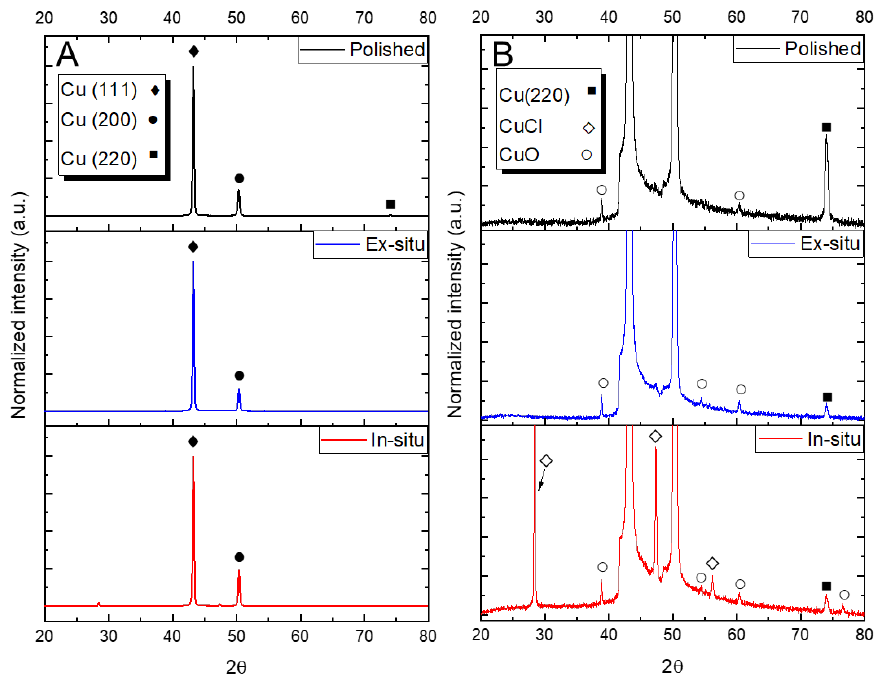
Figure 6. ( A ) Normalized X-ray diffraction pattern for copper surface: polished surface before the reaction (black); corroded surfaces in B = 0 (blue) and B > 0 (red). ( B ) Vertical expansion of the diffractograms of Figure 6A.